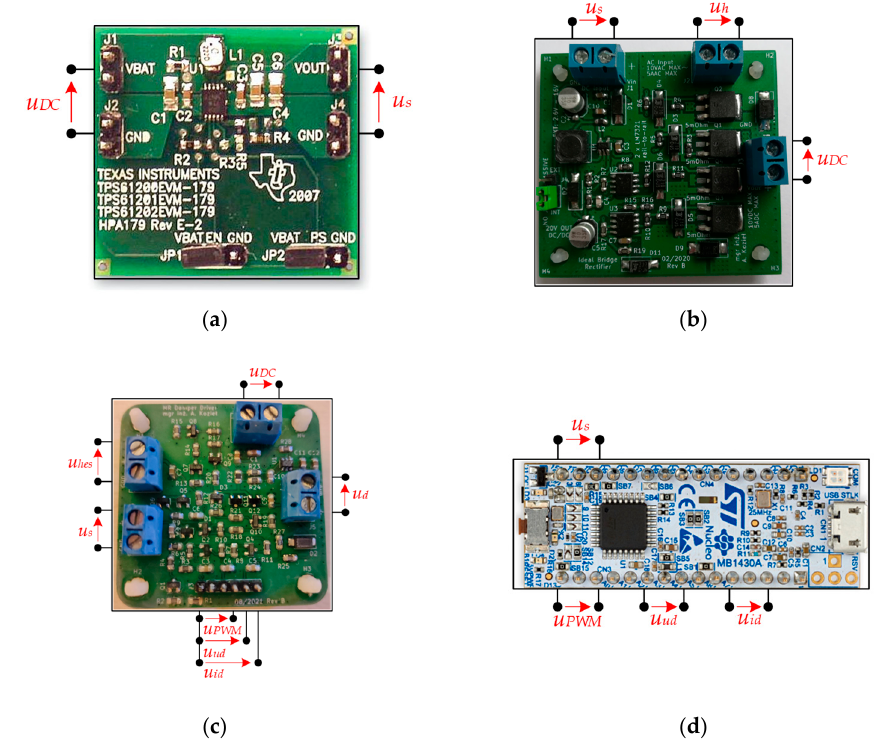
Figure 10. Components of the electrical control unit: ( a ) IPS [25]; ( b ) RB [21]; ( c ) DU; ( d ) µC [24].